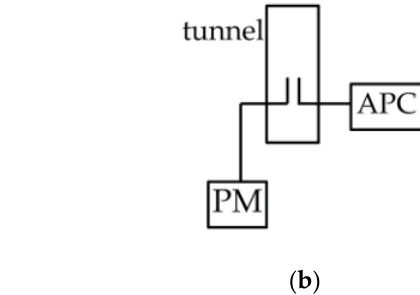
Table 2. Dynamometer settings employed in the two measurement campaigns.